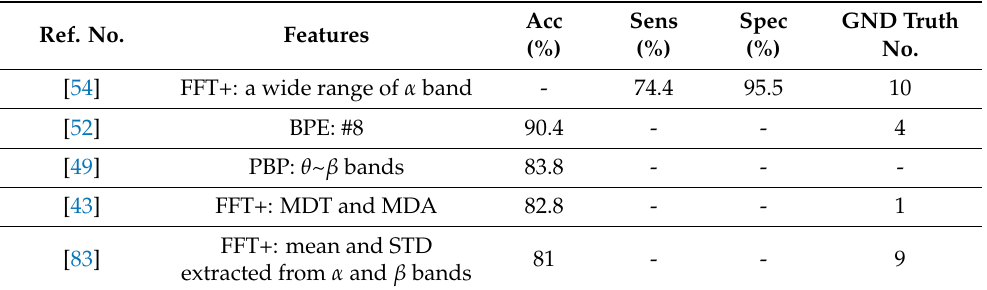
Table 5. EEG-based DDD Accuracies obtained by using Pure Threshold-based Models and Various Features and Ground Truths.